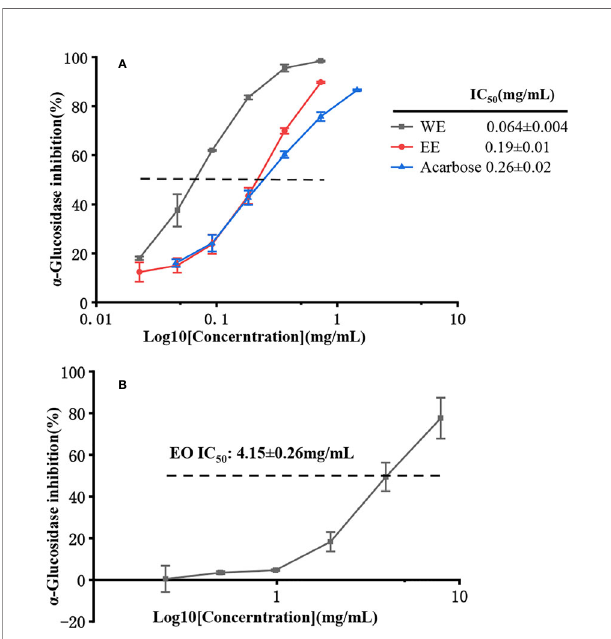
FIGURE 6 | a -Glucosidase inhibitory activity of EO, WE, EE, and acarbose. (A) The inhibitions of WE, EE, and acarbose. (B) The inhibition of